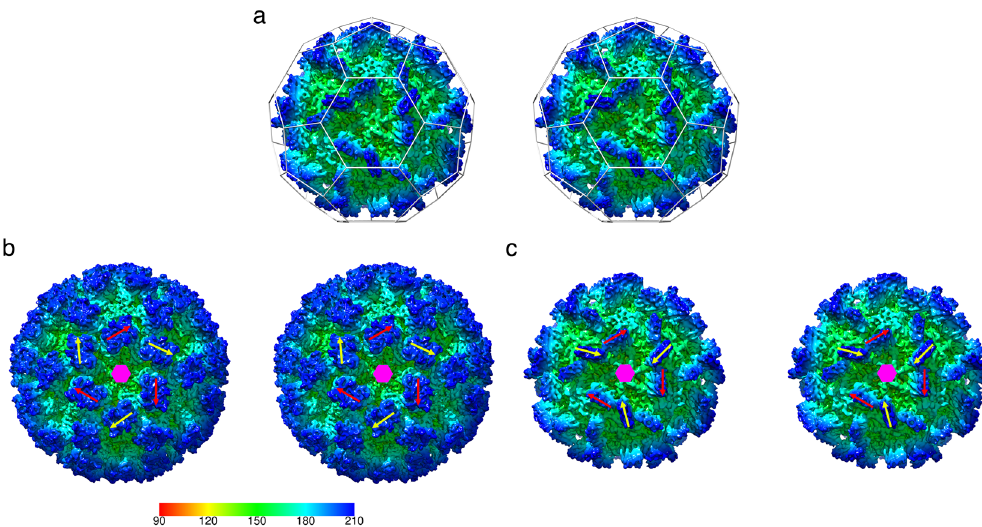
Figure 3. Mr NV P-domains show a pronounced rotation between AB and CC dimers – the quasi-equivalent positions for dimeric capsomeres in a T = 3 icosahedral virus capsid. ( a ) A stereo pair of the Mr NV reconstruction viewed along an icosahedral three-fold symmetry axis. In T = 3 icosahedral capsids, a local six-fold quasi-symmetry axis lies at this point. The locations of icosahedral five-fold and local quasi-six-fold symmetry axes are highlighted by a ‘soccer-ball’ cage. ( b ) Dimer clustered T = 3 icosahedral capsids, such as our recently published structure for feline calicivirus have AB and CC P-dimers arranged alternating about the quasi-six-fold axes. Here the positions of such are indicated by red arrows (AB) and yellow arrows (CC). If the structures of AB and CC dimers are not radically different, we expect the position and orientation of these features to be related by an approximately 60° rotation about the local six-fold symmetry axis (indicated by a pink hexagon). ( c ) In the case of the Mr NV P-dimers, the CC P-dimers are rotated approximately 105° relative to the orientation of the AB P-dimers. The radial colour scheme in panel ( b ) indicates the radial depth cue scale in angstroms for the FCV reconstruction